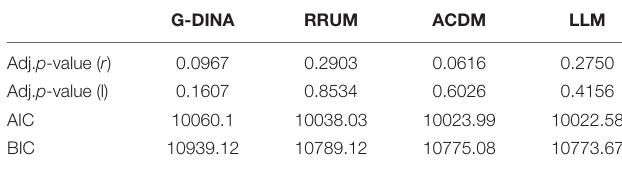
TABLE 6 | Model fit